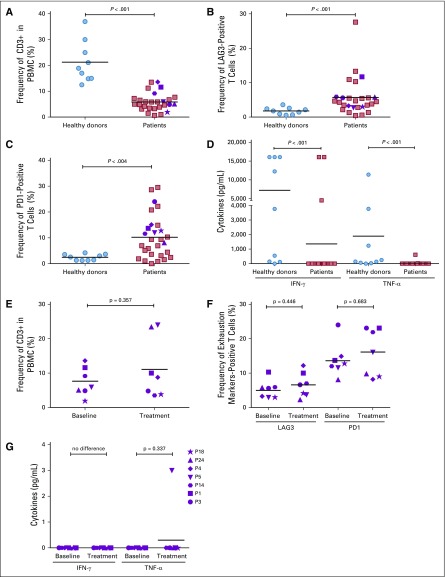
Cell numbers and cytokine expression in healthy controls and trial patients. (A) The frequency of CD3+ T cells in peripheral-blood mononuclear cells (PBMCs) from healthy donors and trial patients. (B) Expression of T-cell surface marker Lymphocyte-activation gene 3 (LAG3) in healthy donors and trial patients. (C) Expression of T-cell surface marker Programmed cell death protein 1 (PD1) in healthy donors and trial patients. (D) Expression of T helper 1 cells (Th1) cytokines interferon (IFN)-γ and tumor necrosis factor (TNF)-α after phorbol 12-myristate 13-acetate ionomycin stimulation in healthy donors and trial patients. (E) Frequency of CD3+ T cells before and after commencement of trial therapy in patients demonstrating a clinical response to trial therapy. (F) Functional status of T cells in patients who demonstrated a clinical response to trial therapy as determined by LAG3 and PD1 expression. (G) Expression of Th1 cytokines IFN-γ and TNF-α after phorbol 12-myristate 13-acetate ionomycin stimulation in patients achieving a clinical response to trial therapy.